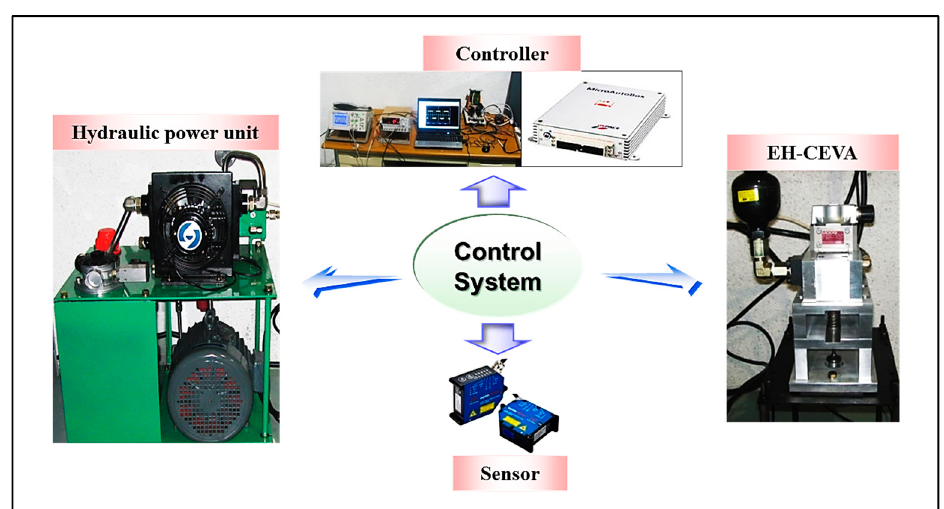
Figure 8. Illustration of the control system.